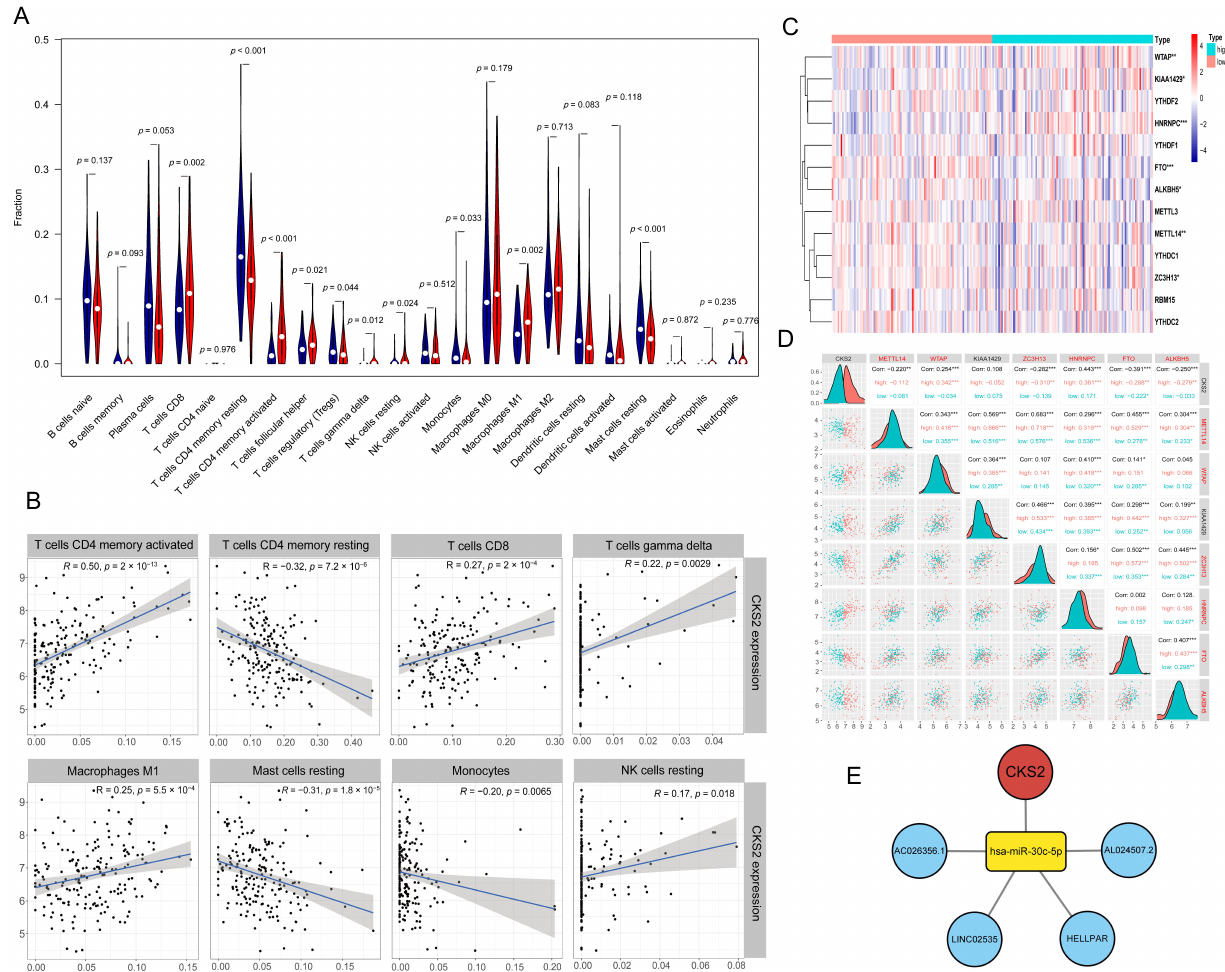
Figure 4. Exploration of the mechanisms for CKS2 overexpression. ( A ) The differences in immune cell abundance between CKS2-low and CKS2-high expression groups. ( B ) Correlation between immune cell abundance and CKS2 expression. ( C ) Heatmap of m6A-related gene expression in CKS2-low and CKS2-high expression groups. ( D ) Relationship between CKS2 expression level and differentially expressed m6a-related genes. ( E ) CeRNA regulatory network of CKS2. * p < 0.05, ** p < 0.01, *** p < 0.001. CeRNA, competing endogenous